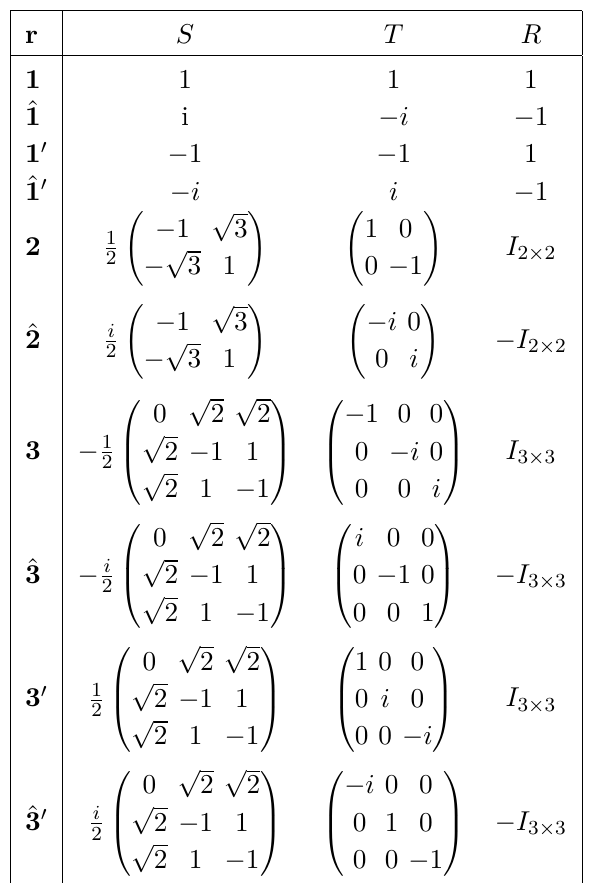
Table 8. The matrix representations of the generators of Γ 0